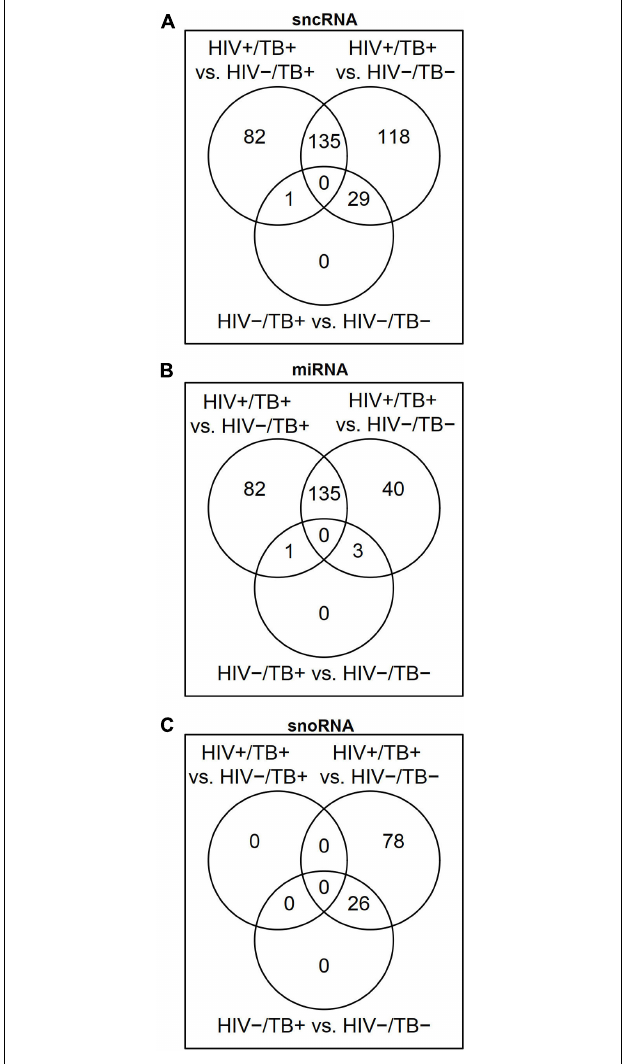
FIGURE 1 | Venn diagrams showing differentially expressed (FDR < 0.05) (A) small non-coding RNAs (sncRNAs), (B) microRNAs (miRNAs), and (C) small nucleolar RNAs (snoRNAs) in the HIV+/TB+, HIV-/TB+ and HIV-/TB-